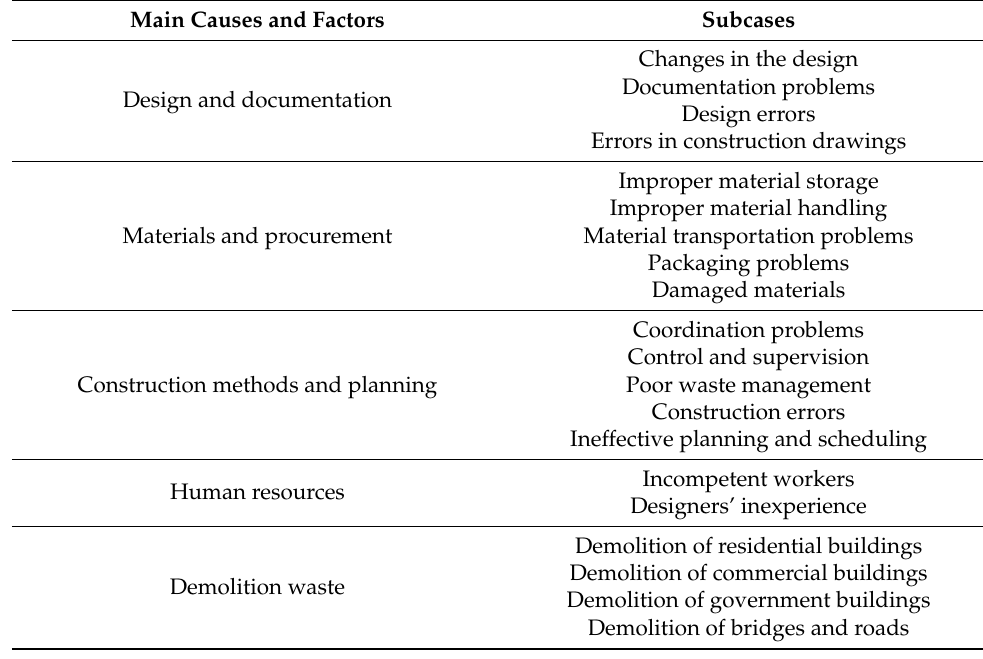
Table 1. C&D waste generation factors.